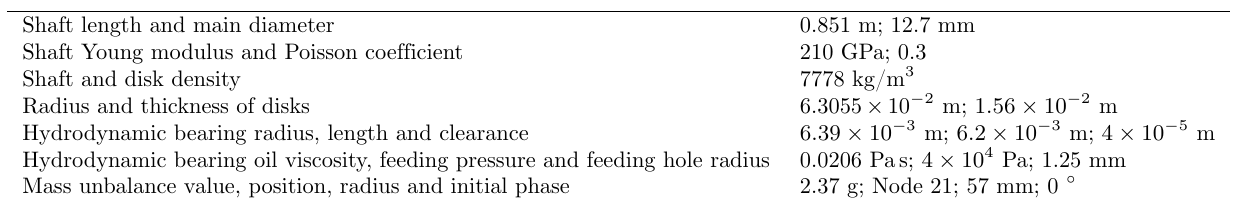
Fig. 2. On-board rotor test bench used for the experimental validations: (a) CAD view and (b) Photo view. Table 1. Main rotor